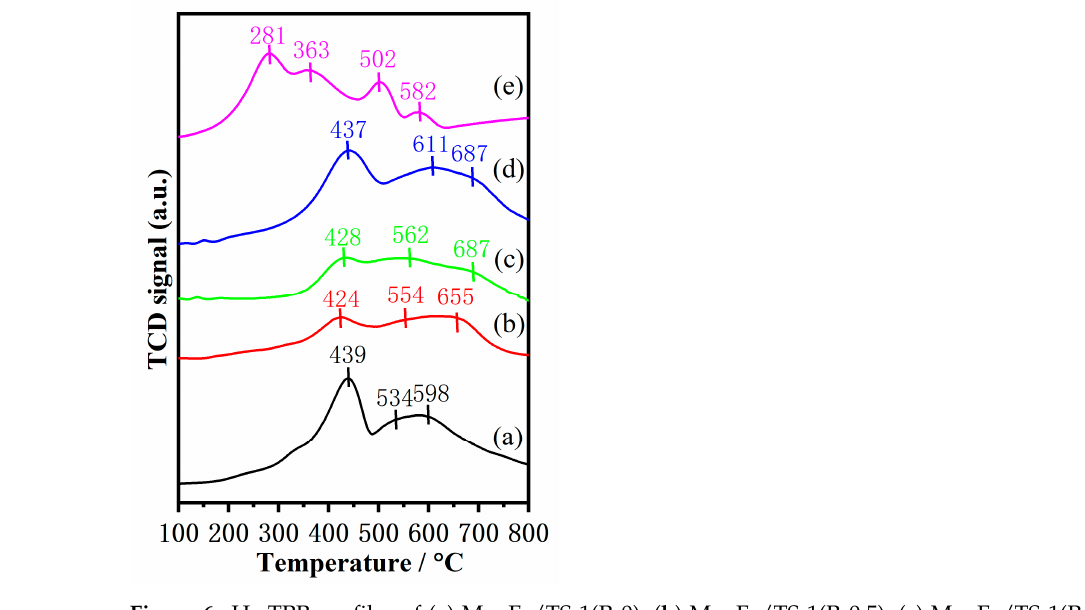
Figure 6. H 2 -TPR profiles of ( a ) Mn–Fe/TS-1(R-0), ( b ) Mn–Fe/TS-1(R-0.5), ( c ) Mn–Fe/TS-1(R-1), ( d ) Mn–Fe/TS-1(R-2), and ( e ) Mn–Fe/TiO 2 . Table 3. Reduction temperature peak and H 2 consumption of the